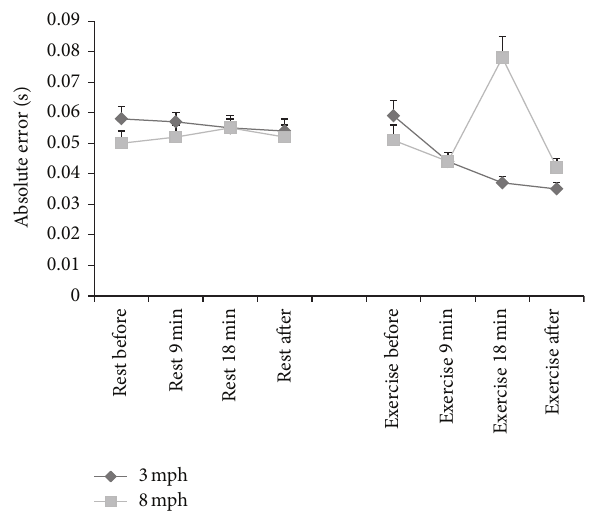
Figure 2: Mean ± SE of absolute error (secs) in rest and exercise conditions,atstimulusspeedsof3and8 mphandinrestandexercise conditions.